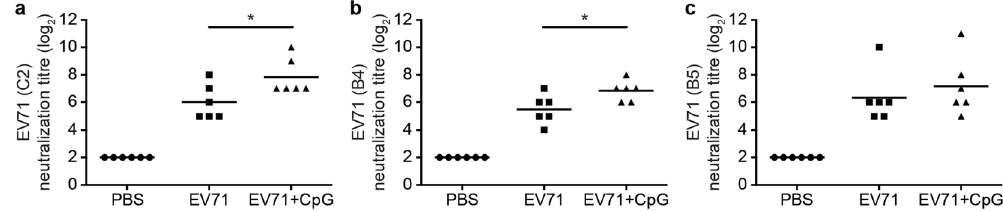
Figure 4. Neutralisation titres of serum antibodies against distinct EV71 strains. ( a ) TW2272/98 (C2 genogroup), ( b ) 200307025 (B4 genogroup), and ( c ) 20080738 (B5 genogroup). Sera were collected from mice at 2 weeks after the third immunisation with PBS or formalin-inactivated EV71 alone or with CpG and were serially diluted (2 3 –2 12 ), mixed with the EV71 virus (strain TW2272/98, 200307025, or 20080738), and used to infect RD cells. After 4 days, the neutralisation titre was read as the highest dilution that resulted in the virus producing no cytopathic effect. Values shown are means ± SEMs of six mice in each experimental group; * p < 0.05. One representative study of three with similar results is shown. RD cells: rhabdomyosarcoma cells.